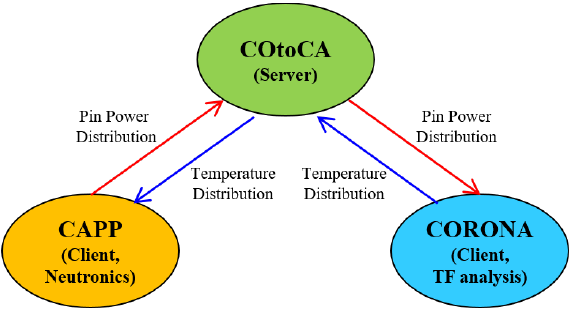
Figure 3. CORONA/CAPP Coupled Code System